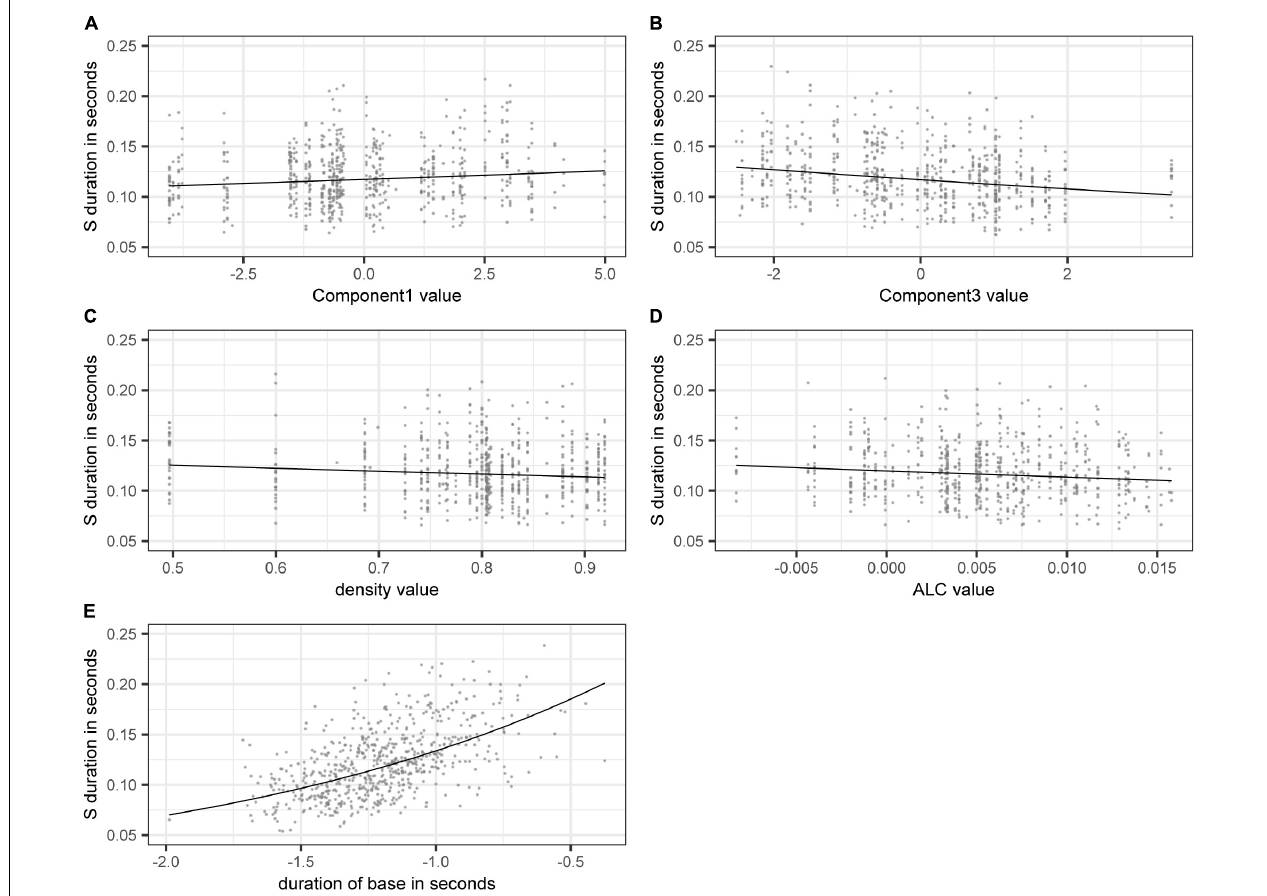
FIGURE 3 | Partial effects of the numerical variables included in the final “LDL measures and AFFIX” model, fitted to the log-transformed values of duration of S. (A) C OMPONENT 1 (B) C OMPONENT 3 (C) DENSITY (D) ALC (E) back-transformed BASE D UR L OG